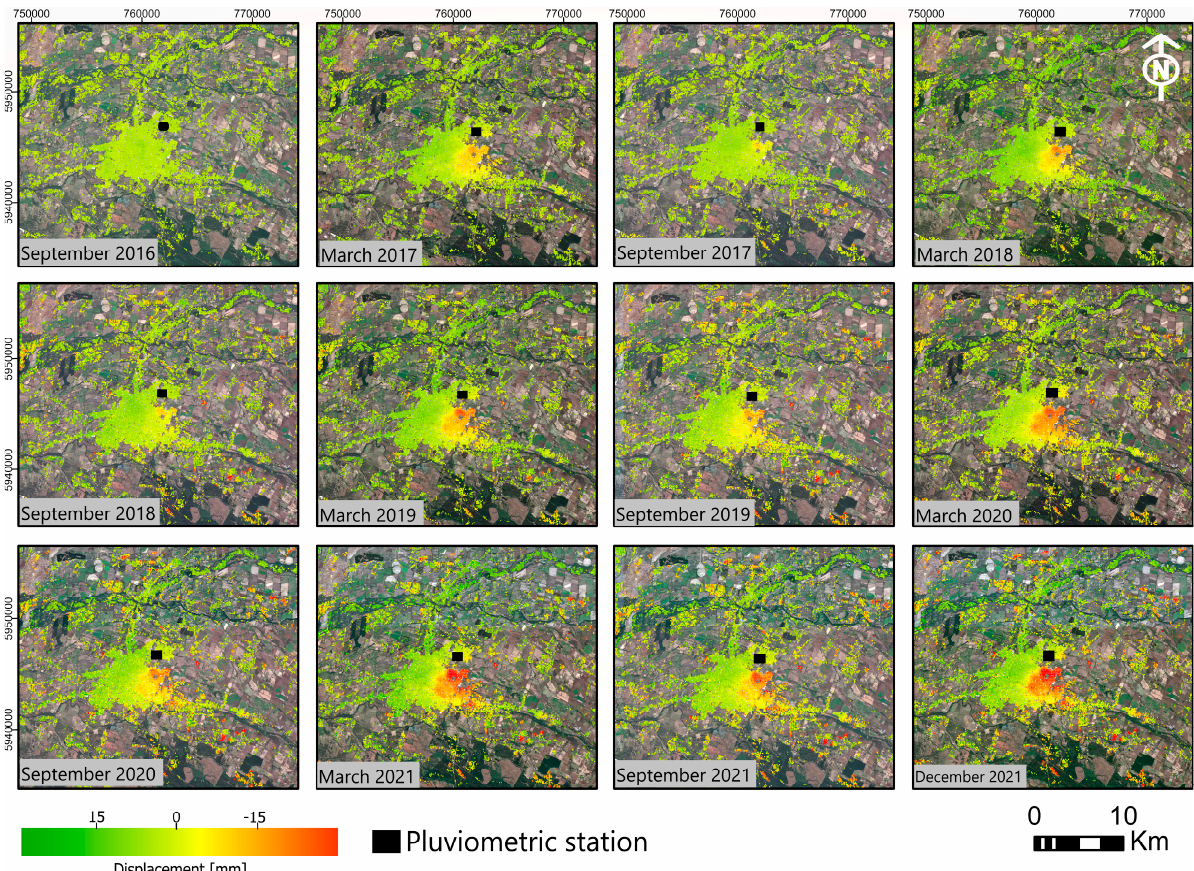
Figure 9. Seasonal variations map, winter (September) and summer (February–December), back- ground Sentinel 2 image ESA (2022).